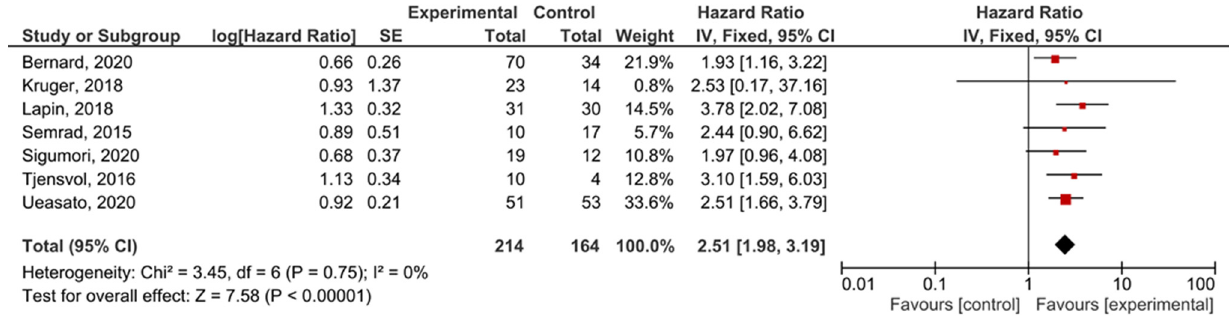
Figure 8. Forest plot presenting the relationship between the presence of KRAS mutations before treatment in locally- advanced and metastatic PDAC patients and PFS.